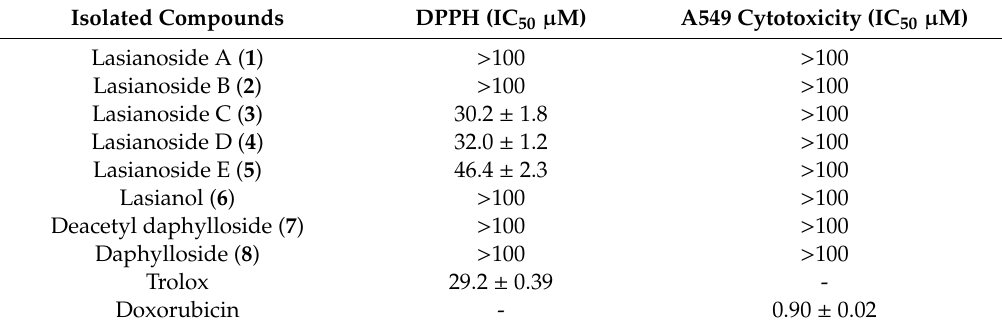
Table 3. Bioactivities of isolated compounds 1 – 8 ( n = 3 ) * . DPPH: 1,1-diphenyl-2-picrylhydrazyl. Isolated